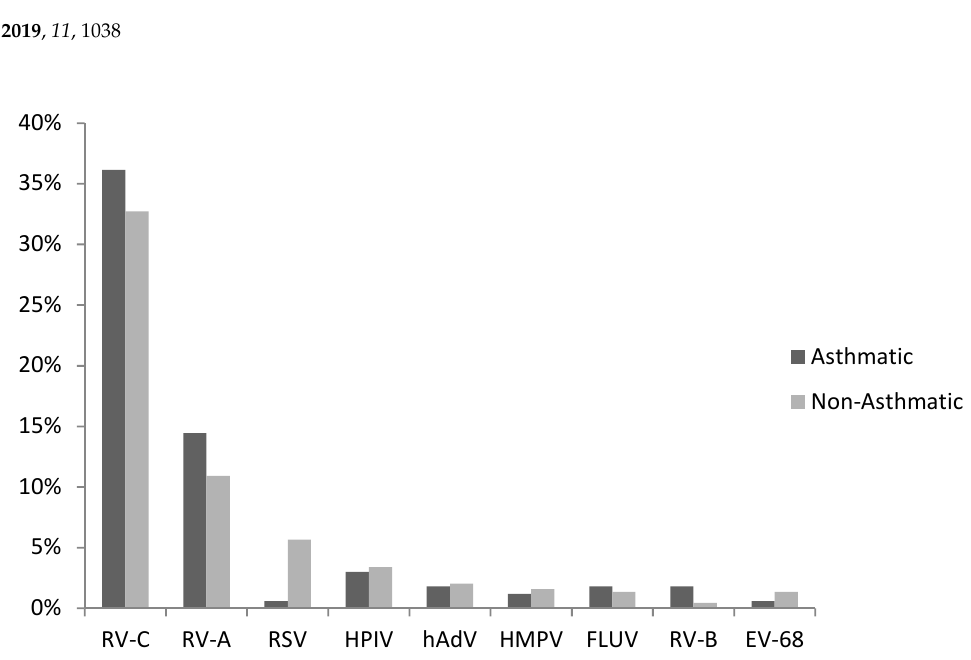
Figure 1. Respiratory virus detection rates in children presenting to the ED with a respiratory wheezing illness. RV-C was the predominant virus pathogen detected. Abbreviations: rhinovirus (RV), respiratory syncytial virus (RSV), human metapneumovirus (hMPV), adenovirus (ADV), human parainfluenza virus (HPIV), influenza viruses (IFV), human coronavirus (hCoV), and HBoV (human bocavirus).